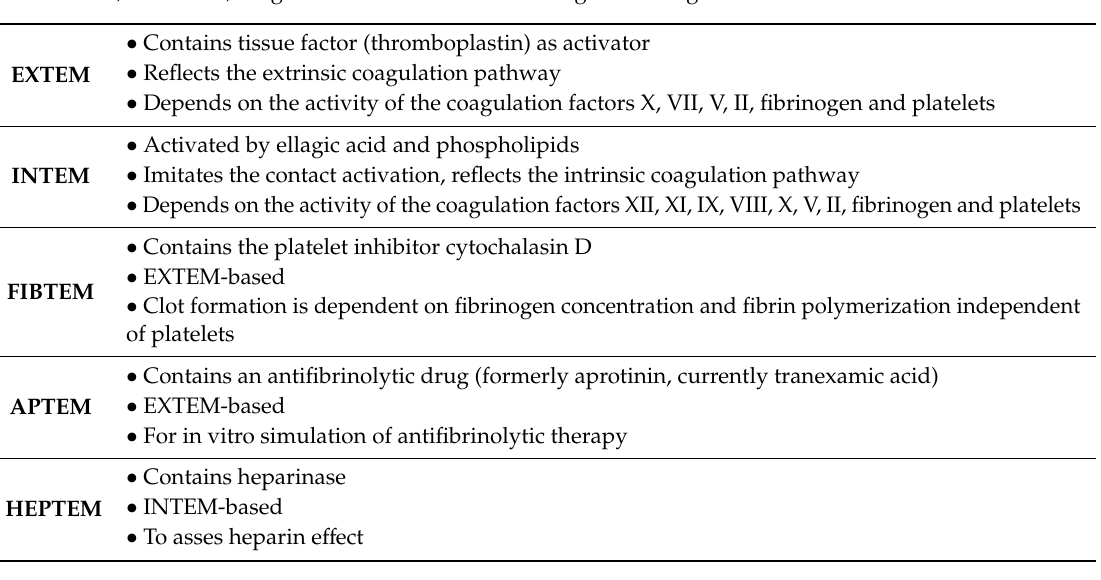
Table 1. ROTEM ® Assays. The left column lists the main tests with the corresponding descriptions of content, activation, coagulation determinants and usage on the right column.